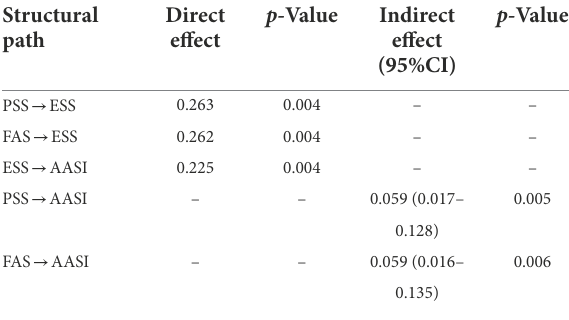
TABLE 4 Effects estimate of hypothesized model (standardized